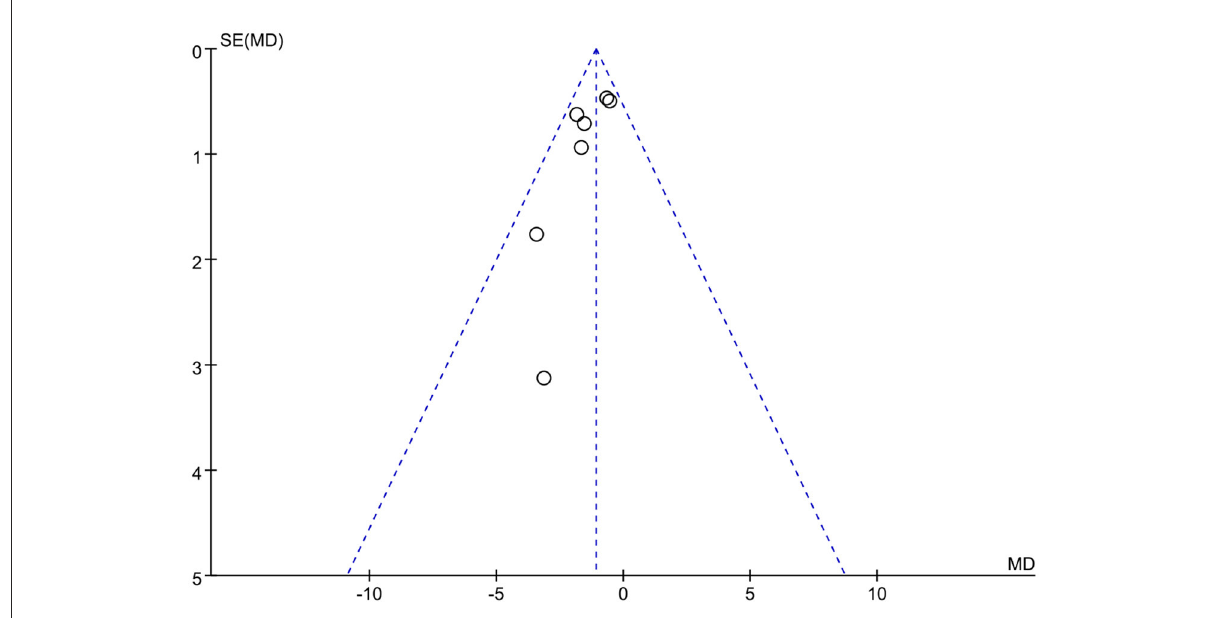
FIGURE9 Funnel plot to detect risk of publication bias in the